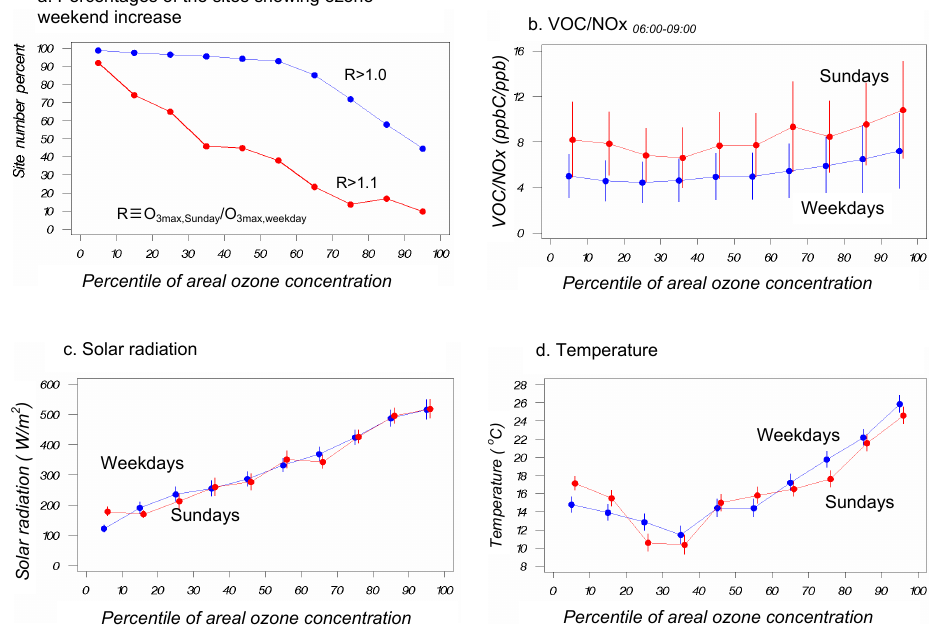
Fig. 4. Variation of parameters with the regional ozone concentration percentile rank in the TMA (see Fig. 3a) during 1999–2004. (a) Percentage of sites showing an ozone weekend increase among 308 monitoring sites. (b) Mean VOC/NO x during 06:00–09:00LT on weekdays and Sundays at 180 monitoring sites. (c) Mean solar radiation at 21 monitoring sites. (d) Mean temperature at 179 monitoring sites. In b), c) and d), the error bars show the standard deviation (SD).